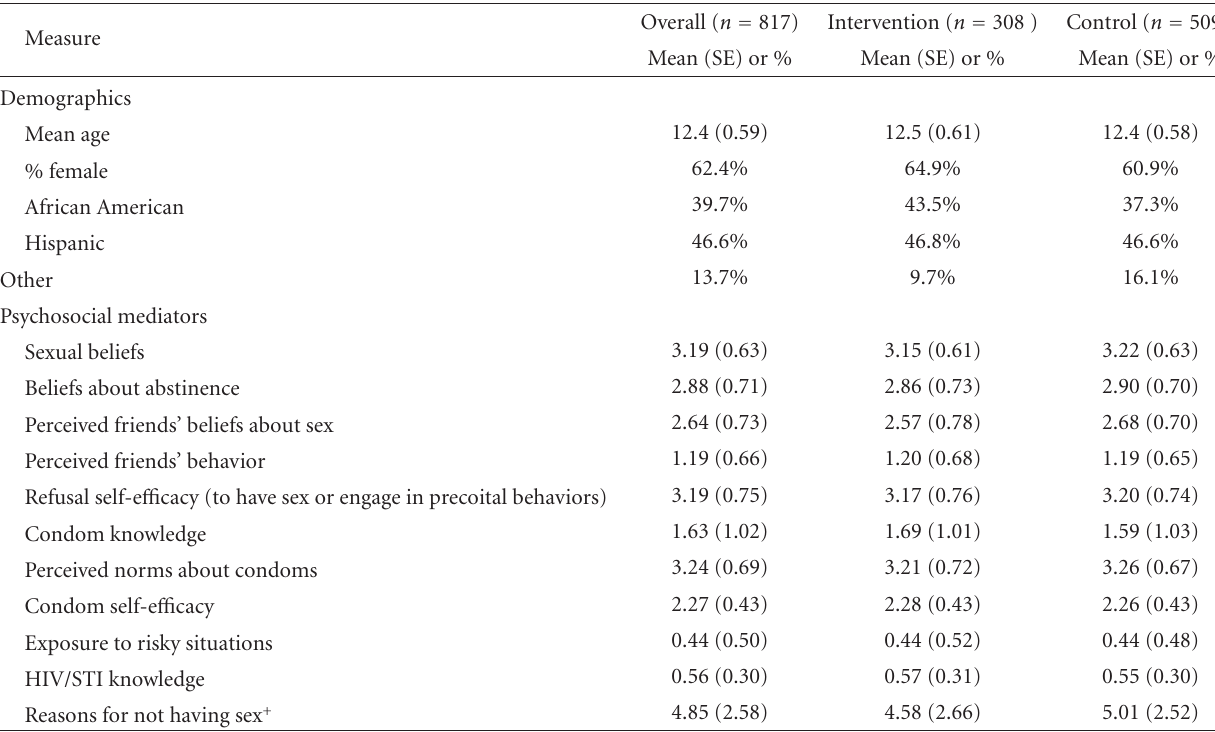
Table 2: Study descriptives of analysis sample at